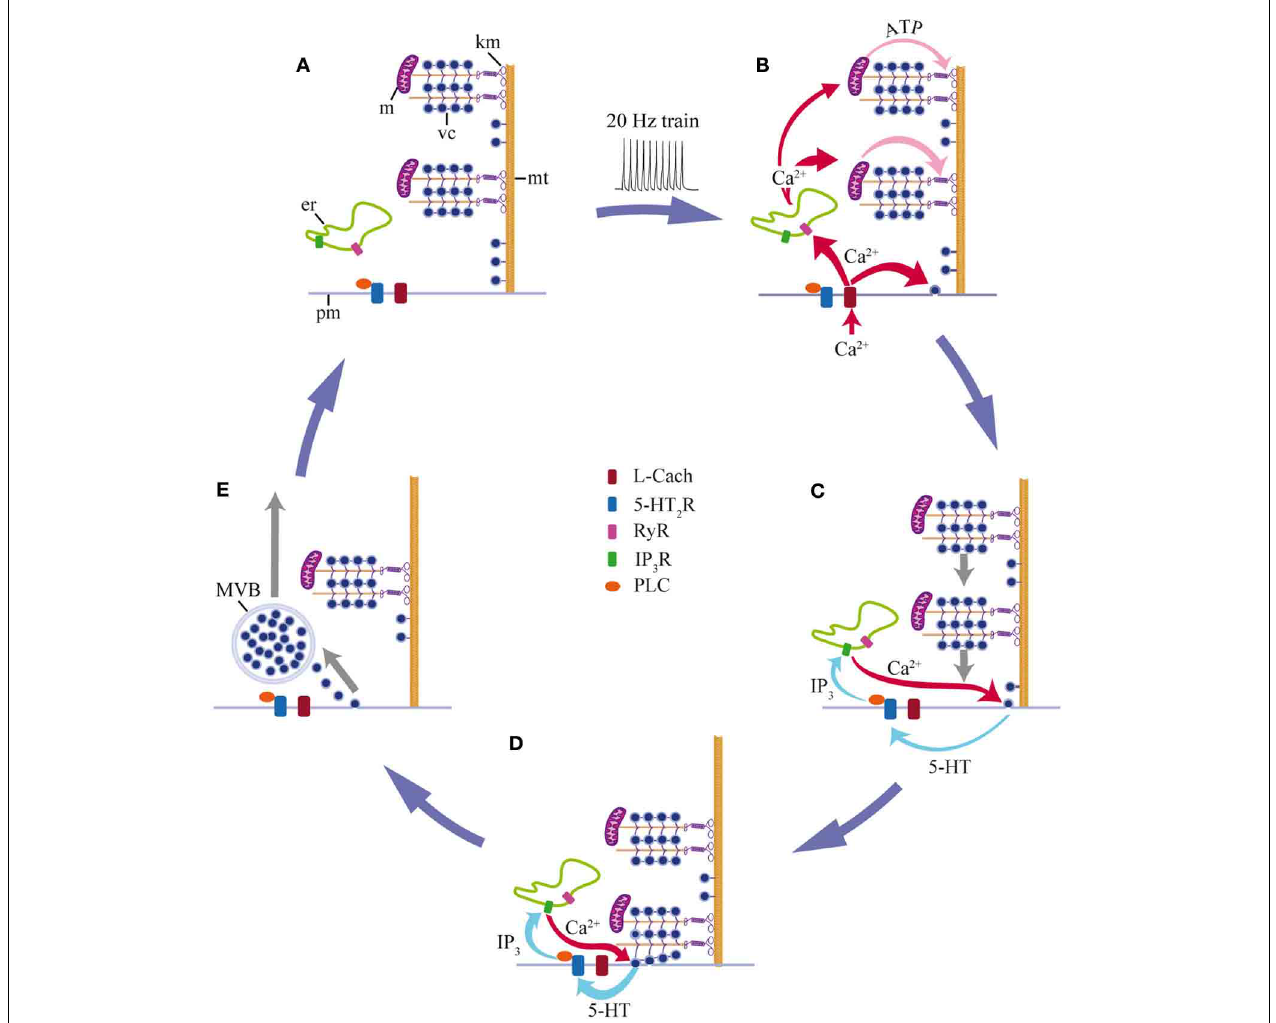
FIGURE 7 | Schematic representation of the mechanism for somatic 5-HT exocytosis by Retzius neurons. (A) At rest, vesicle clusters (vc) and mitochondria (m) are distant from the plasma membrane. Both are attached to microtubules (mt) that arrive at the plasma membrane (pm). Endoplasmic reticulum (er) rests between the plasma membrane and the vesicle clusters. (B) A train of impulses evokes transmembrane Ca 2 + entry through L-type channels (L Cach). Ca 2 + triggers exocytosis from vesicles that are close to the plasma membrane and in parallel, Ca 2 + entry activates ryanodine receptors (RyR) and Ca 2 + -induced Ca 2 + release, presumably from endoplasmic reticulum. The fast Ca 2 + transient reaches the mitochondria (m), which responds by producing ATP. Kinesin motors (km) become activated. (C) Vesicle clusters are transported toward the plasma membrane. The peripheral vesicle clusters and mitochondria receive more Ca 2 + and ATP than the